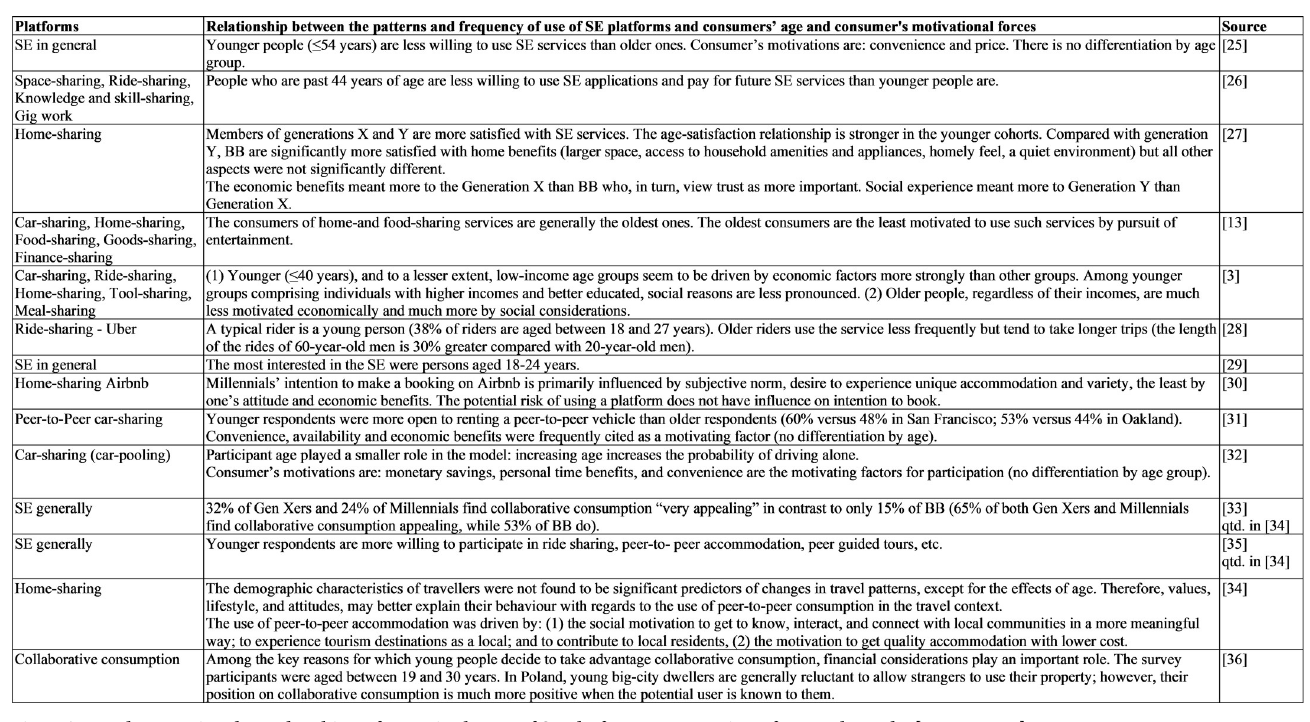
PLOS ONE | https://doi.org/10.1371/journal.pone.0265341 June 9,